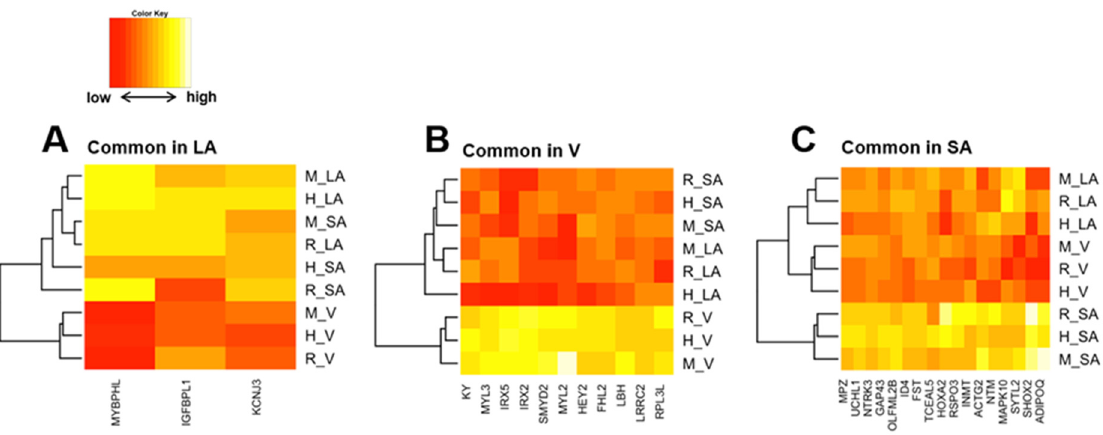
Figure 6. ( A ) is a heat map of z-score normalized SPM values in left atrial (LA)-specific genes that are common across species. Similarly, ( B ) and ( C ) show ventricle-specific gene groups and sinoatrial node (SA)-specific gene groups, respectively.